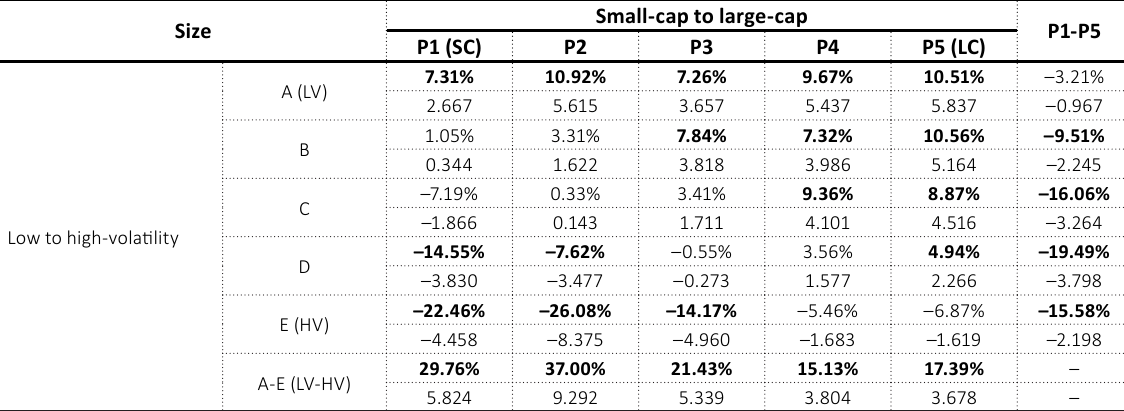
Table 8. Three-factor alpha of quintile portfolios independently sorted on size and volatility